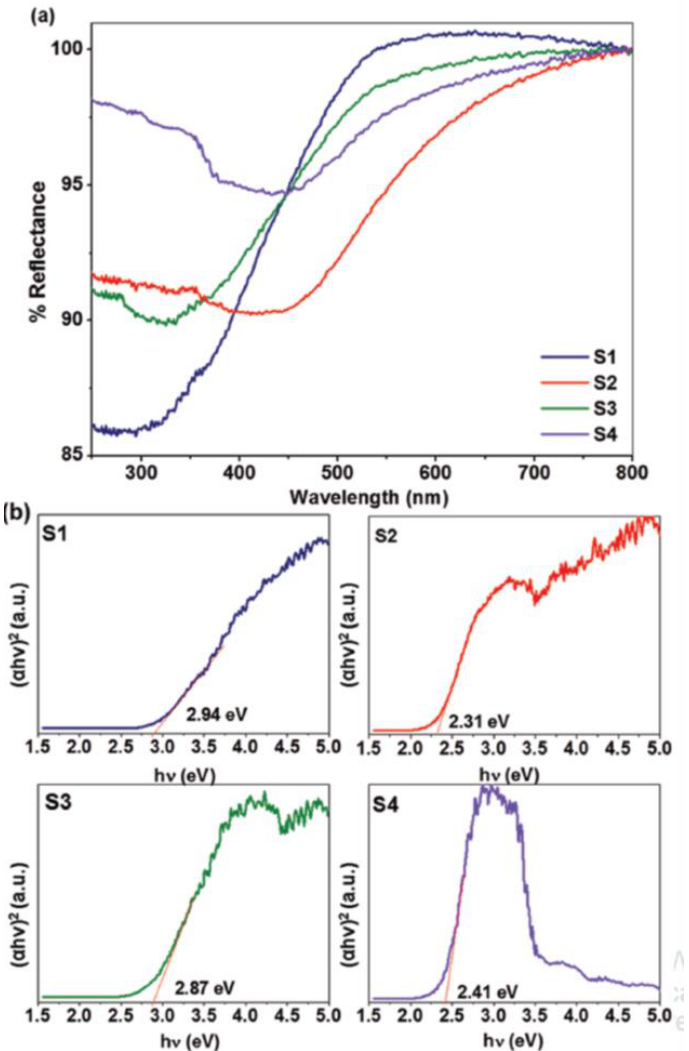
Figure 26. ( a ) DRS spectra and ( b ) Tauc plots for SnS 2 nanoparticles synthesized by using different reactants and solvents. Reproduced with permission from